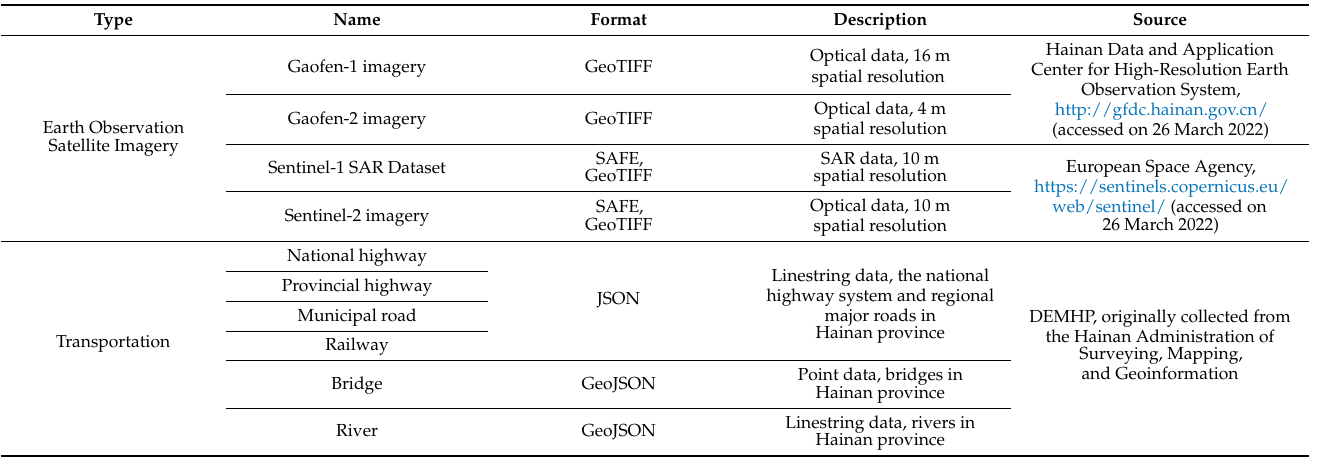
Table 3. Fundamental data used in RDDSS